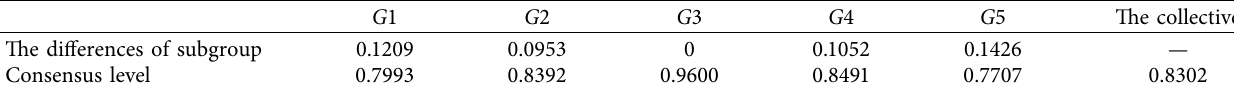
Table 5: .e initial consensus levels.